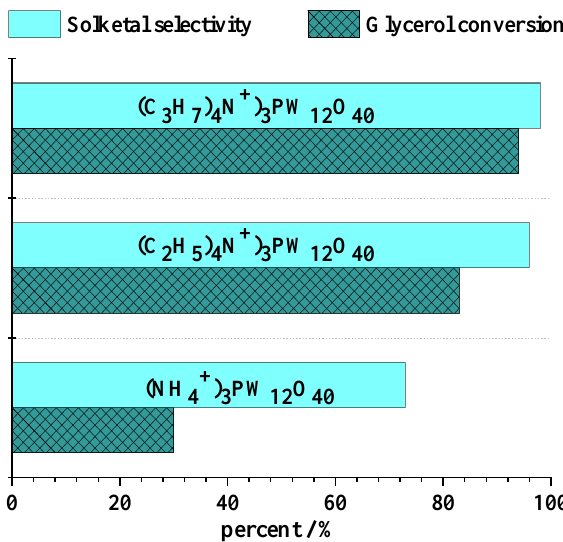
Figure 25. Catalytic activities of ammonium phosphotungstate and organic phosphotungstate salts in carbonation reactions of glycerol with urea. Reaction conditions: Glycerol: acetone molar ratio (1:6); temperature (303 K); catalyst load (3 wt% related to the glycerol); reaction time (120 min) (adapted from ref. [71]).